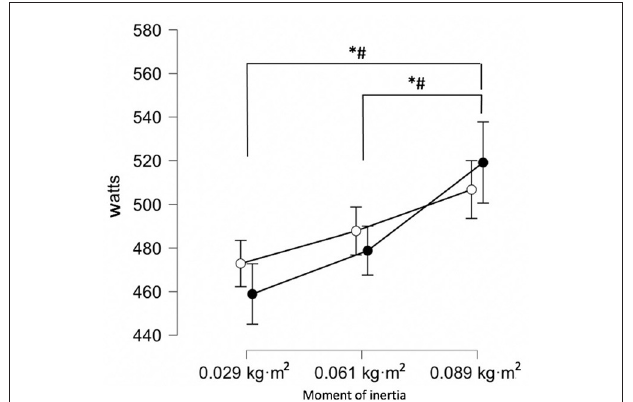
FIGURE 3 | Concentric and eccentric peak power output during unilateral flywheel hip extension. *Statistically significant ( p < 0.05) difference between concentric peak power. # Statistically significant ( p < 0.05) difference between eccentric peak power. Black dots = eccentric peak power output. White dots = concentric peak power output.